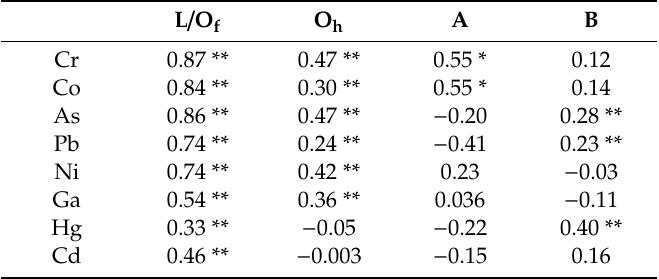
Table 2. Spearman correlations coe ffi cients on the association between heavy elements concentration and U concentration for the four horizons (L / O f , O h , A, and B). Significant di ff erences were indicated by ** p ≤ 0.01, * p ≤